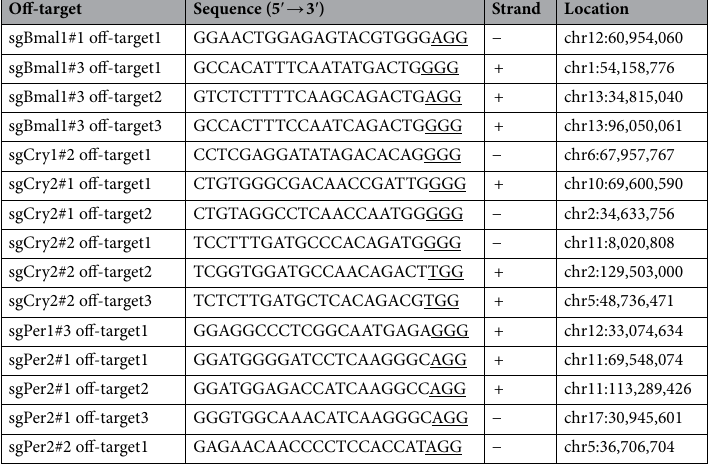
Table 2. Nucleotide sequences of predicted off-target sites of sgRNAs selected for CSAC. Underlined sequences indicated PAM sequence. Strand denotes whether sgRNA recognizes sense (+) or anti-sense (−) strand of target gene. Red characters indicate mismatch to on-target